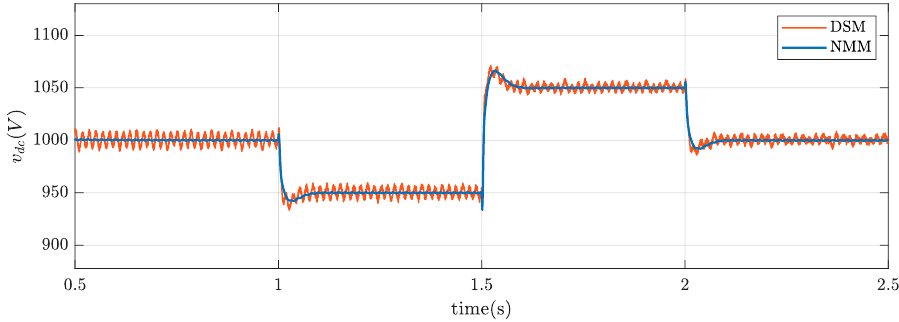
Figure 19. Comparison of NMM dynamics to that of the DSM for step change in DC link reference voltage v dc .